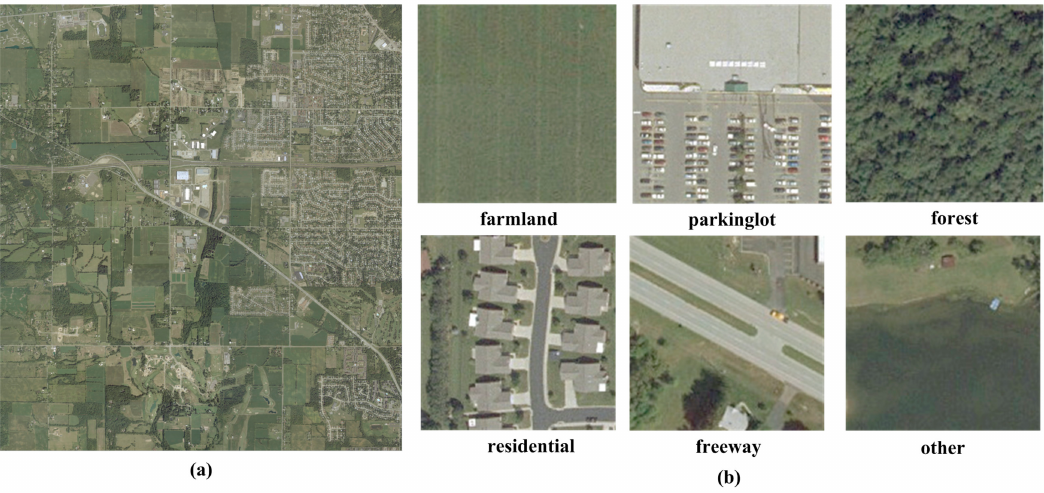
Figure 10. Sample images of the WHU-RS dataset in the target domain with 19 categories. ( a ) Original image; and ( b ) sample images of six land-use categories.